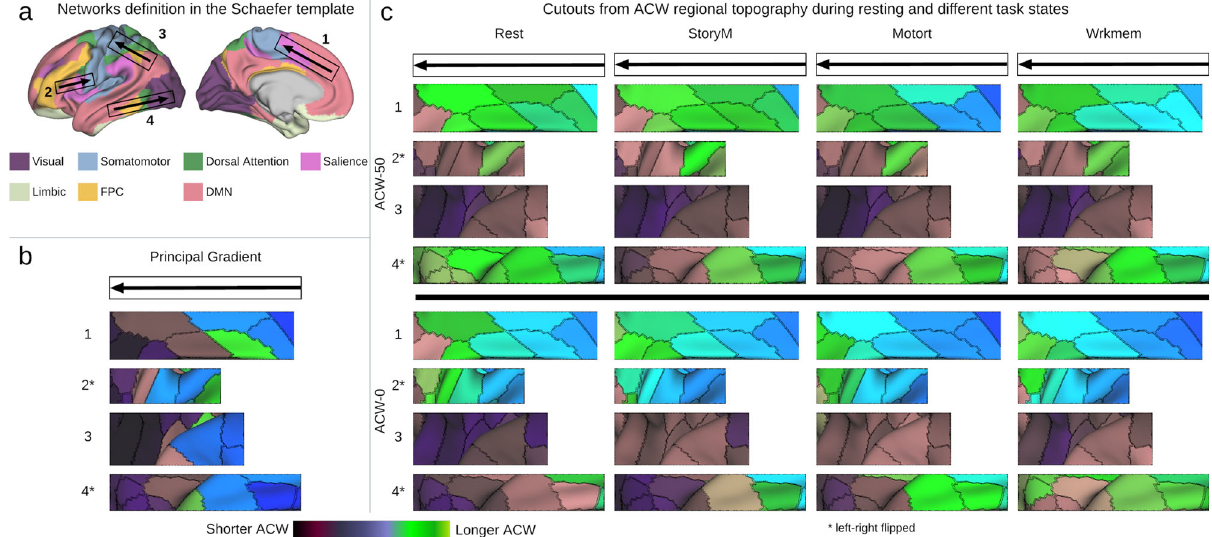
Fig. 3 ACW cutouts for principal gradient of functional connectivity. The cutouts are similar to Fig. 3c of ref. 14 . They suggest that the direction of cross- regional changes in ACW is similar to the principal gradient of functional connectivity de fi ned in ref. 14 further validating the presence of the core – periphery organization in ACW. a Networks and the cutouts on the brain. b The regional principal gradient from the cutouts. c regional ACW values from the